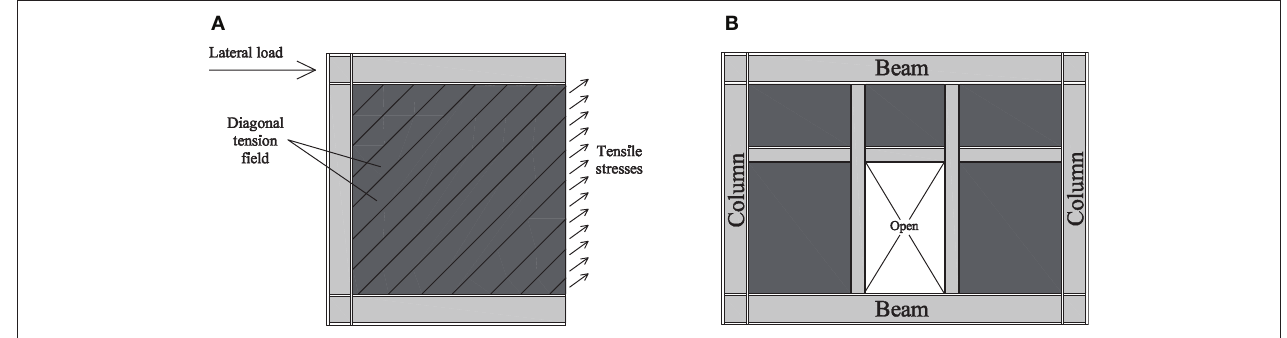
FIGURE 1 | (A) Diagonal tension field of a typical SPSW, (B) Fully-stiffened SPSW with door